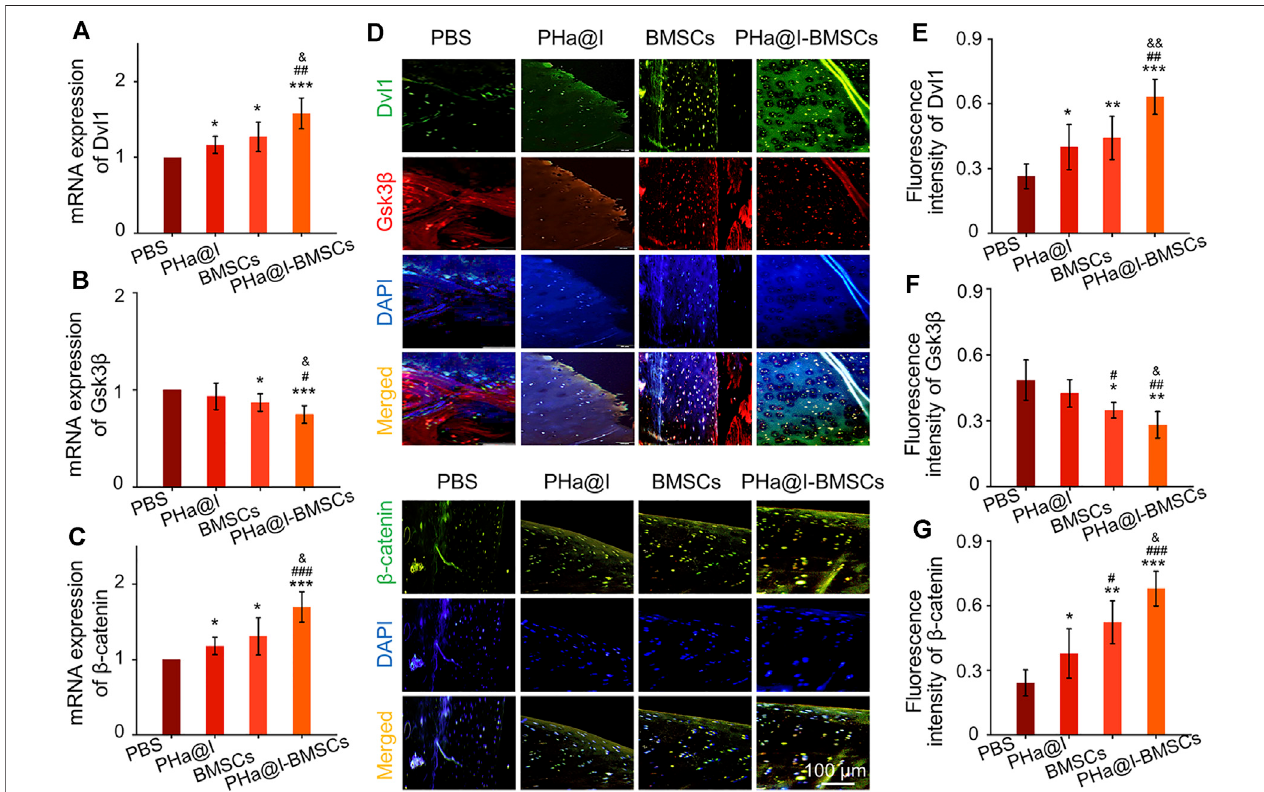
FIGURE 7 | The Wnt/ β -catenin signaling was signi fi cantly activated in the PHa@I-BMSCs Group. (A – C) RT-qPCR analysis Wnt/ β -catenin signaling pathway- relatedgenes Dvl , GSK-3 β ,and β -catenin incartilageat12 weekspost-injection. (D) Representativedoubleimmuno fl uorescenceimagesofDvl,GSK-3 β ,and β -catenin incartilageat12 weekspost-injection. (E – G) Quantitativeanalysisof fl uorescenceintensityofDvl,GSK-3 β ,and β -catenininimmuno fl uorescencestaining(* p < .05,** p < .01,and*** p < .001comparedwiththePBSGroup; # p < .05, ## p < .01,and ### p < .001comparedwiththePHa@IGroup; & p < .05and && p < .01comparedwiththe BMSC Group, n =